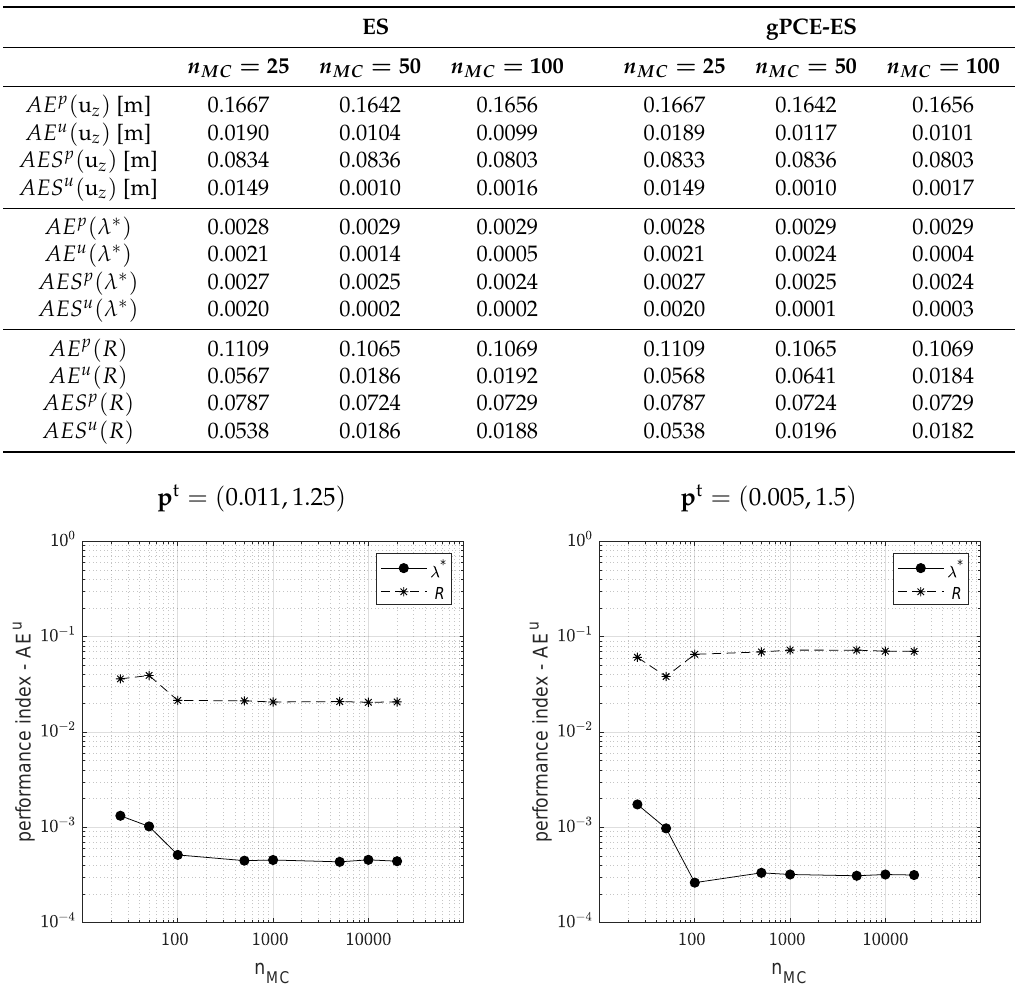
Table 2. Values of AE and AES (prior and update) for the state and parameter ensembles computed by ES and gPCE-ES.